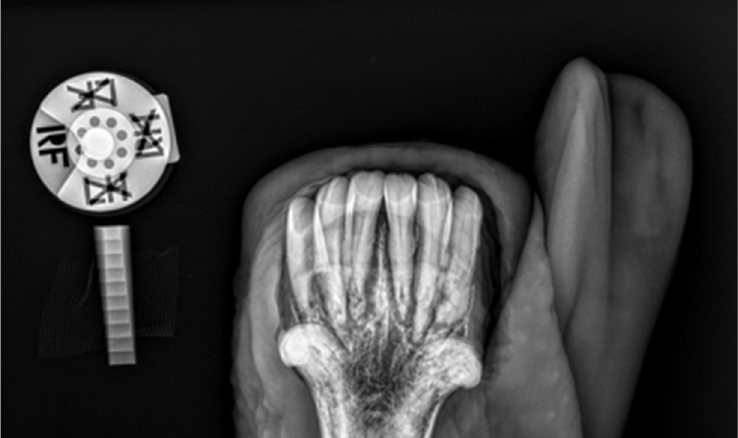
Figure 4. Case 1—intraoral radiograph of mandibular incisor teeth. Radiolucent areas around the tooth roots, indicating extensive resorption, erosion of the apical part of the root, irregular and rough surface of an intra ‐ alveolar part.